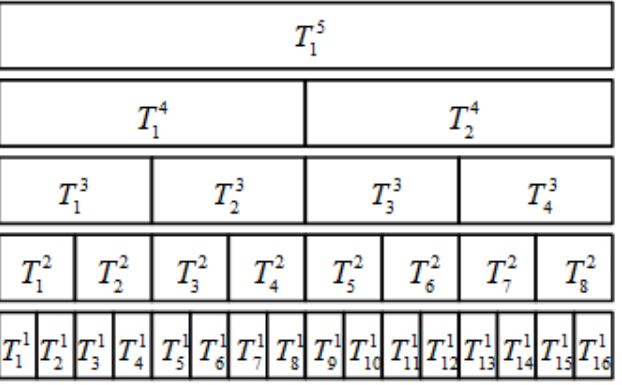
Figure 2. The multilevel partition (for every single-phase cable).